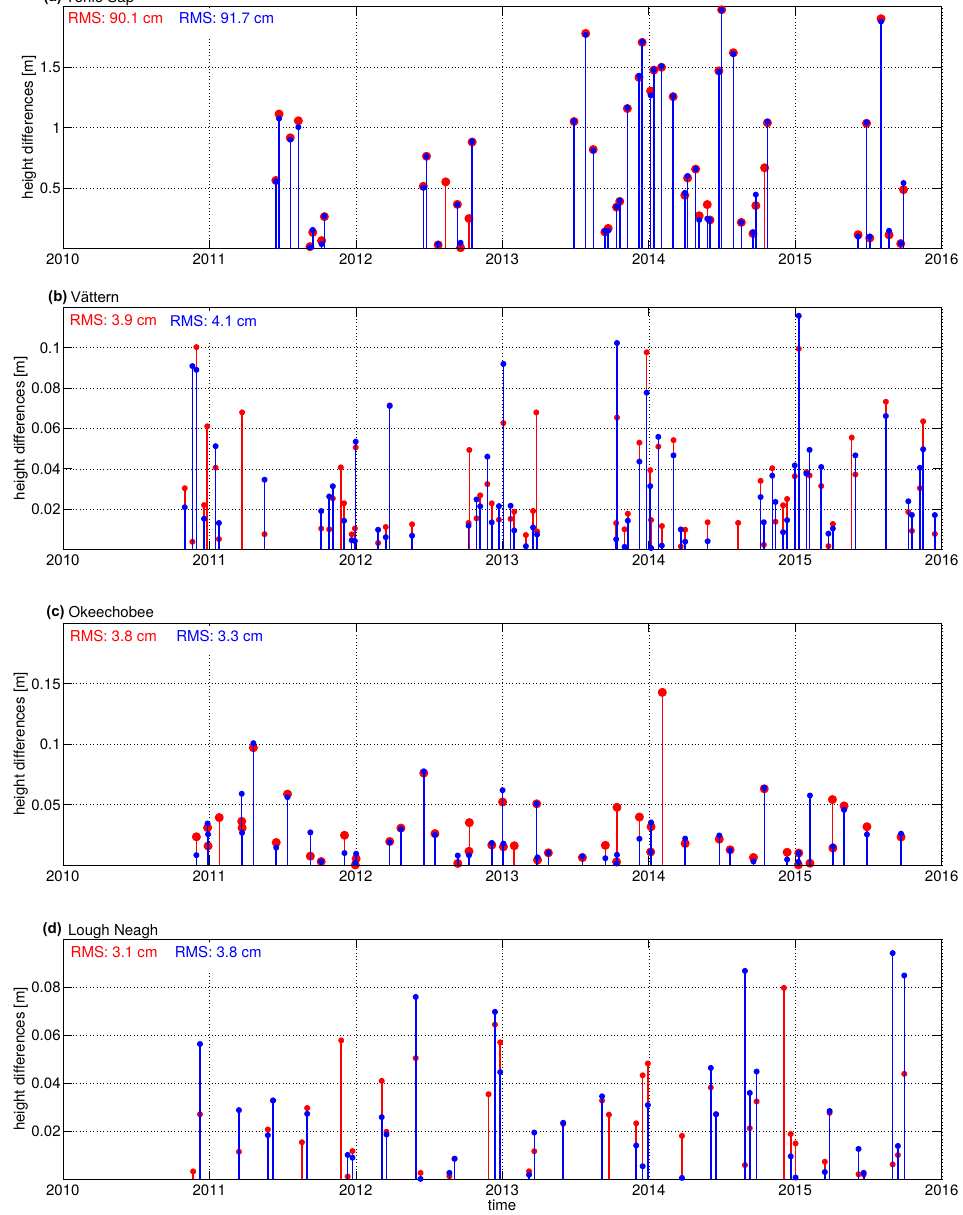
(a) Tonle Sap RMS: 90.1 cm RMS: 91.7 cm